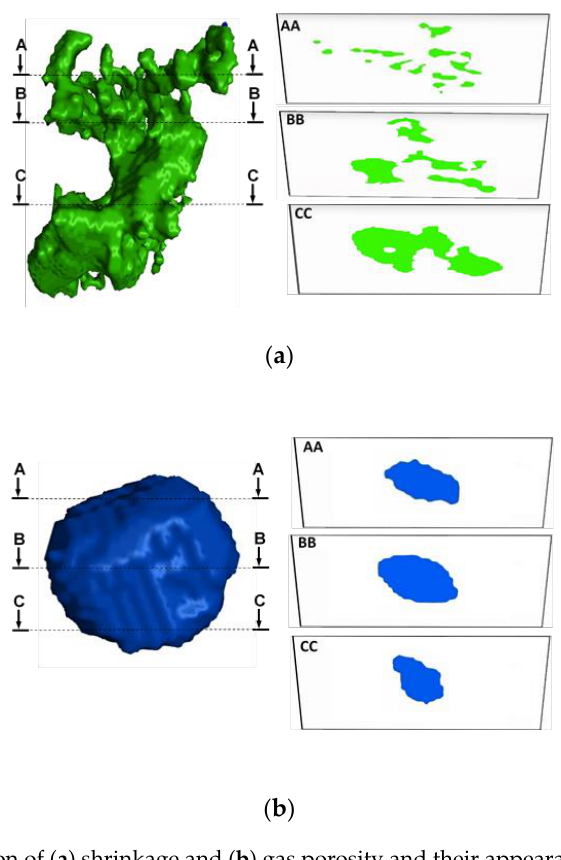
Figure 6. Illustration of ( a ) shrinkage and ( b ) gas porosity and their appearance on 2D surfaces.